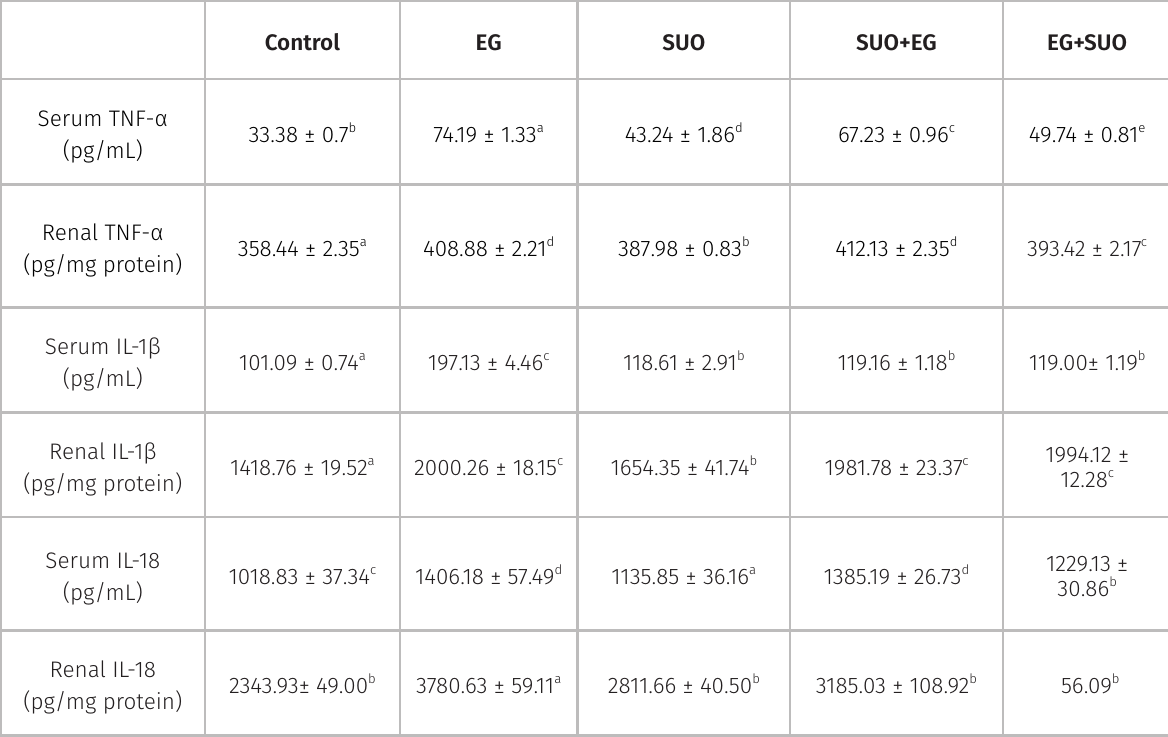
Table IV. Serum and Kidney Tissue Inflammatory Cytokine (TNF-α, IL-1β ve IL-18)